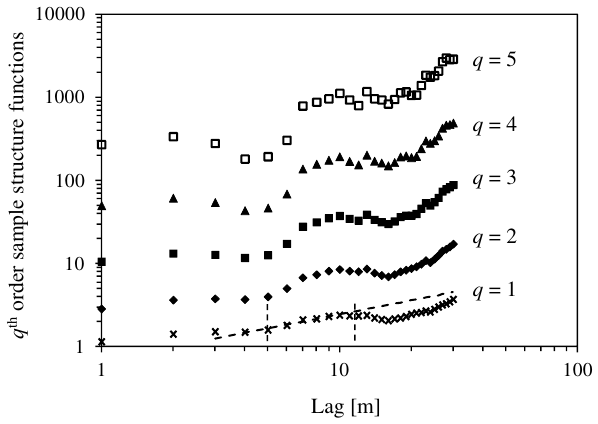
Fig. 4. Sample structure functions of orders q =1, 2, 3, 4, 5 of Ari- zona data versus lag. Light vertical broken lines demarcate mid- range of lags within which heavy inclined broken line, with slope taken to represent ξ ( 1 ) , was fitted to S 1